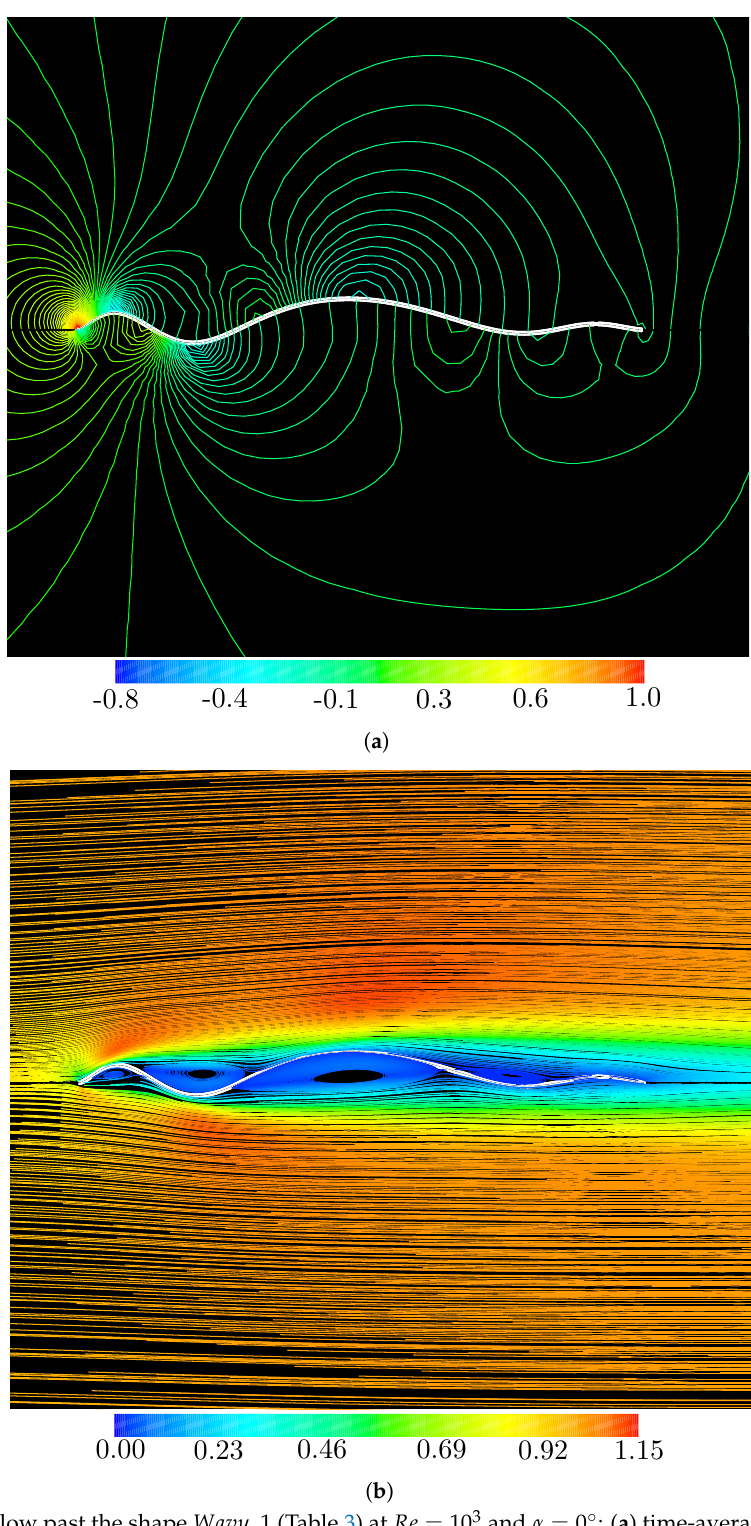
Figure 11. Flow past the shape Wavy _1 (Table 3) at Re = 10 3 and α = 0 ◦ : ( a ) time-averaged pressure isolines; and ( b ) time-averaged